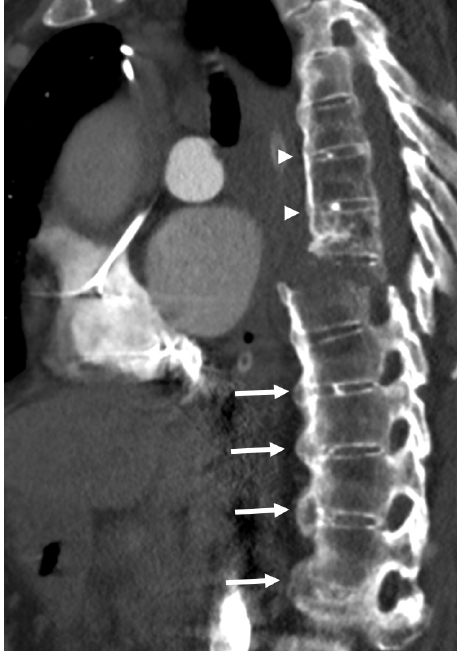
Figure 6. Sagittal CT reconstruction of the thoracic spine of a 78-year-old patient with thoracic DISH after low-energy trauma, showing an unstable extension-type fracture of the mid-thoracic spine. In the given slice, there are two vertically oriented bony bridges in the upper thoracic spine (arrowheads) that may lead to the misconception that this is a patient with ankylosing spondylitis; however, there are clearly many flowing osteophytes compatible with DISH in the lower part of the thoracic spine (arrows).